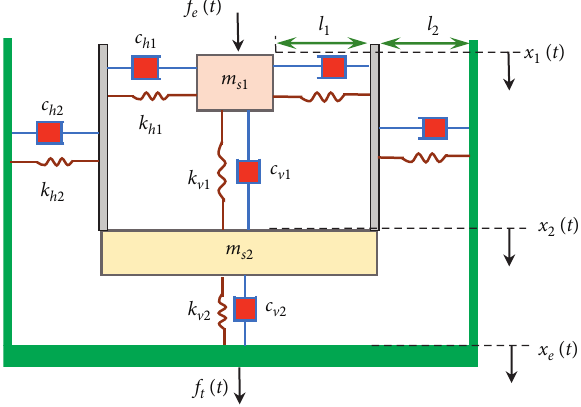
Figure 1: Model of a two-stage nonlinear vibration